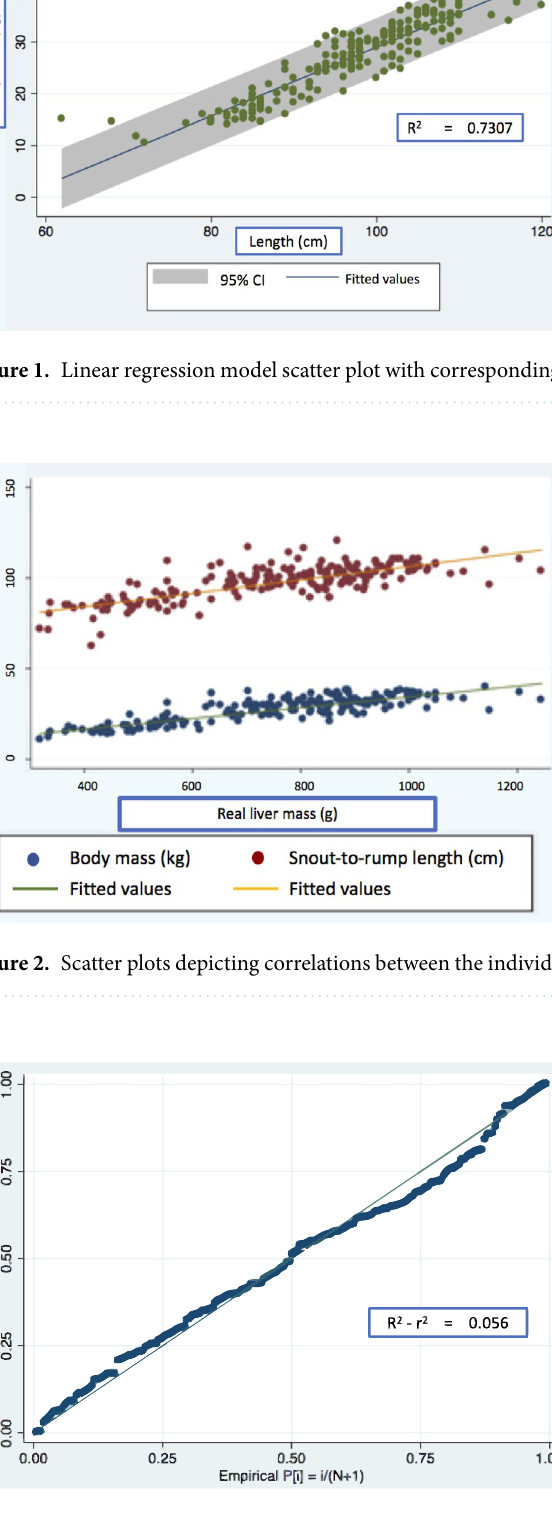
Figure 3. Regression model residuals plot. No significant variation of residuals was